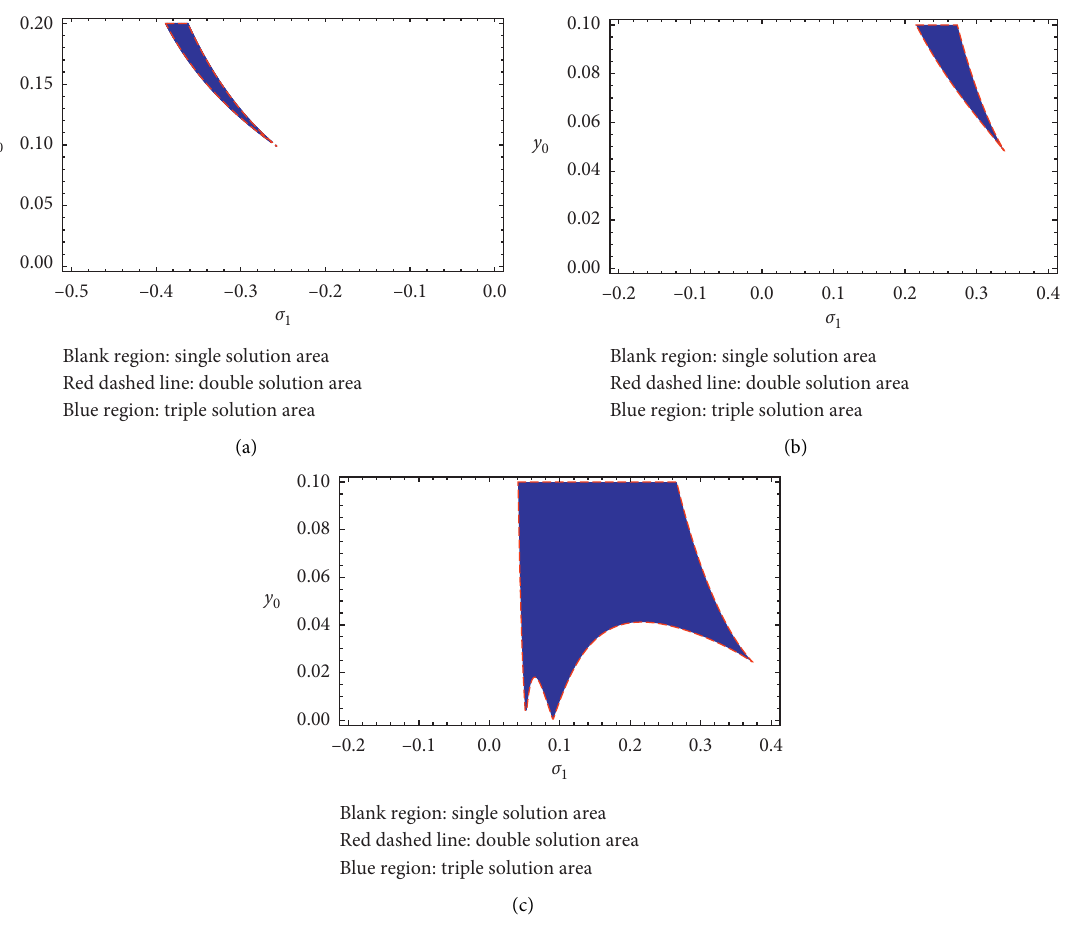
Figure 6: The system solution behavior in y controlled system with τ � τ